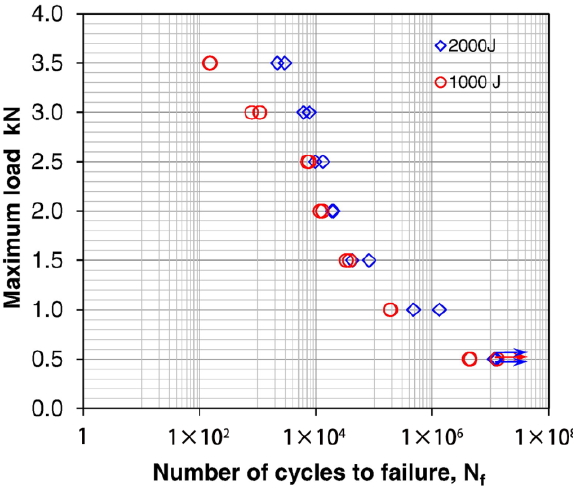
Figure 27. S-N curves of the Al-to-HSLA-steel USW joints